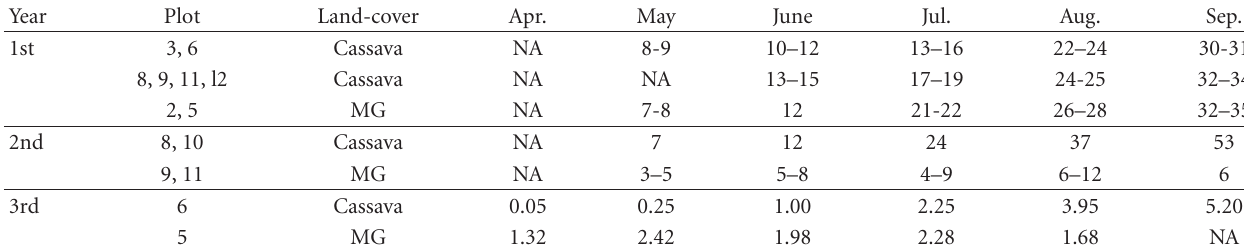
Table 2: Monthly canopy cover ratio (%) or LAI of the planted plots during the rainy season.